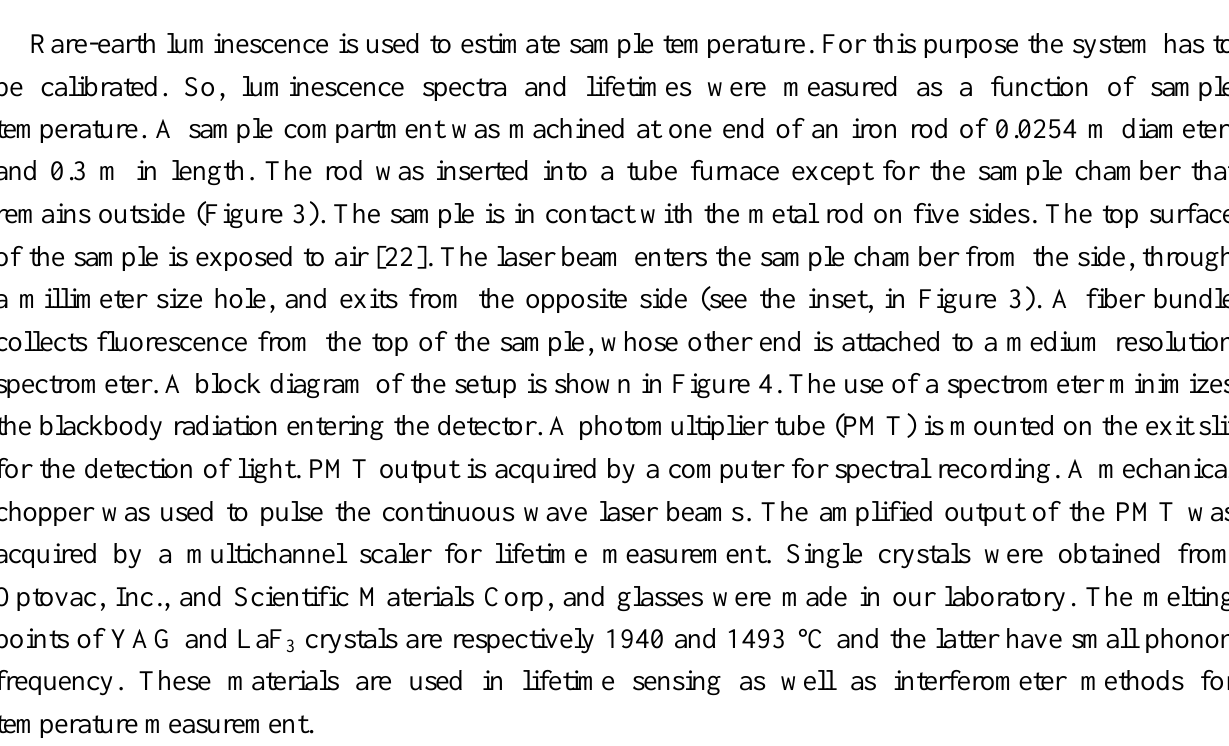
Figure 3. Photograph of the sample heating chamber in fluorescence lifetime sensing setup. Inset shows the sample compartment [22].